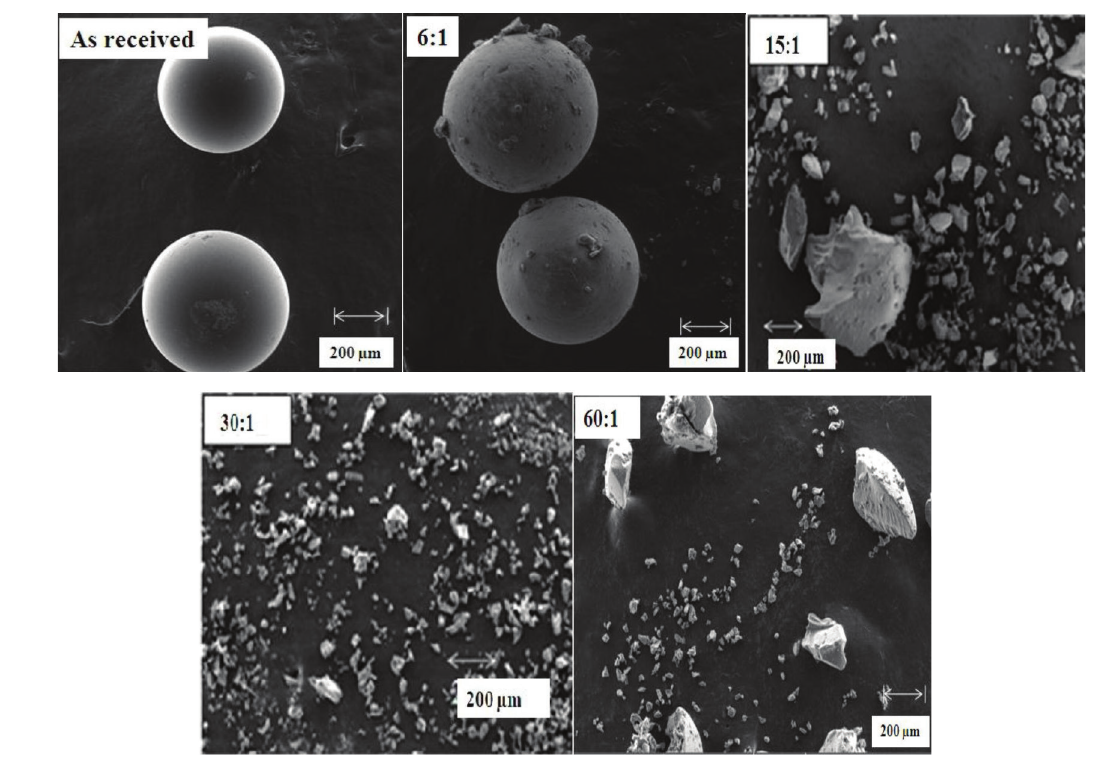
Fig. 5 – SEM analysis of Amberlyst15 (as-received) catalyst and methanol pretreatment with 6:1, 15:1, 30:1, and 60:1 methanol to oil ratio